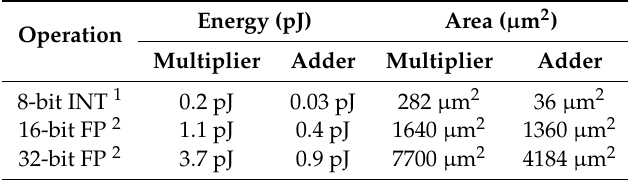
Table 2. Rough relative cost in 45 nm 0.9 V from Eyeriss [20].